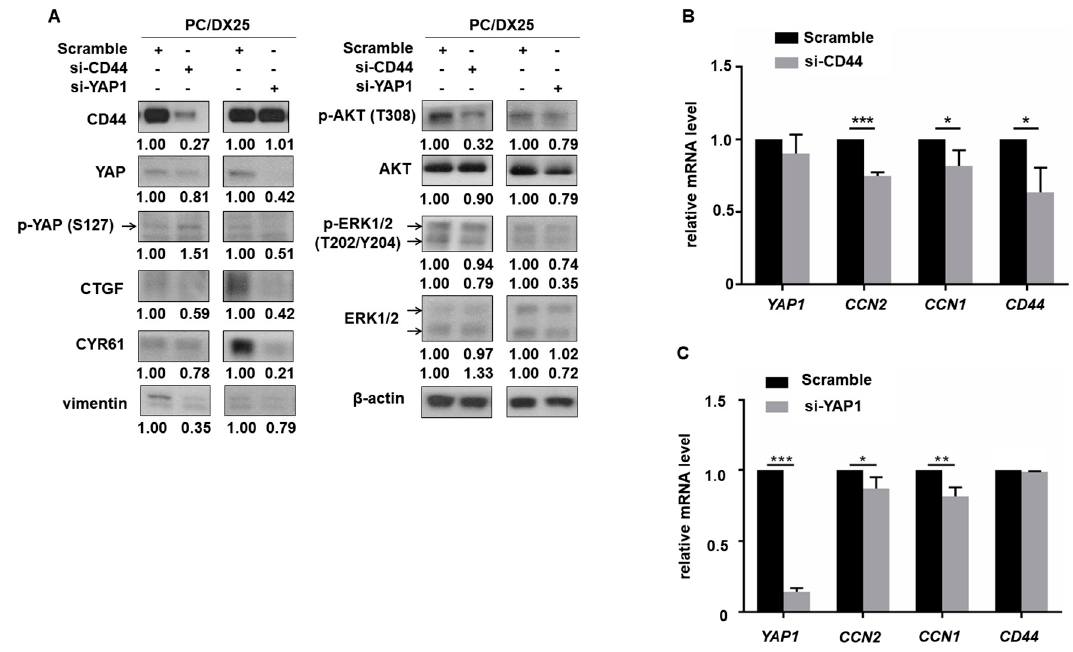
Figure 5. Knockdown of CD44 protein in docetaxel-resistant PCa cells inhibits Hippo-YAP signaling pathway. ( A ) Protein level of CD44, YAP, phospho-YAP (S127), CYR61, CTGF, phospho-AKT (T308), AKT, phospho-ERK1/2 (T202/Y204), ERK1/2 and vimentin in PC/DX25 cells with or without CD44 siRNA knockdown or YAP siRNA knockdown was determined by Western blotting. Expression of β -actin was used as loading control for all Western blots. ( B ) Gene expression level of YAP1 , CCN2 , CCN1 , and CD44 in PC/DX25 cells with CD44 siRNA knockdown or ( C ) PC/DX25 cells with YAP siRNA knockdown was examined by qRT-PCR. Asterisks *, **, *** represent statistically significant difference of p value < 0.05, p value < 0.01, and p value < 0.001, respectively.